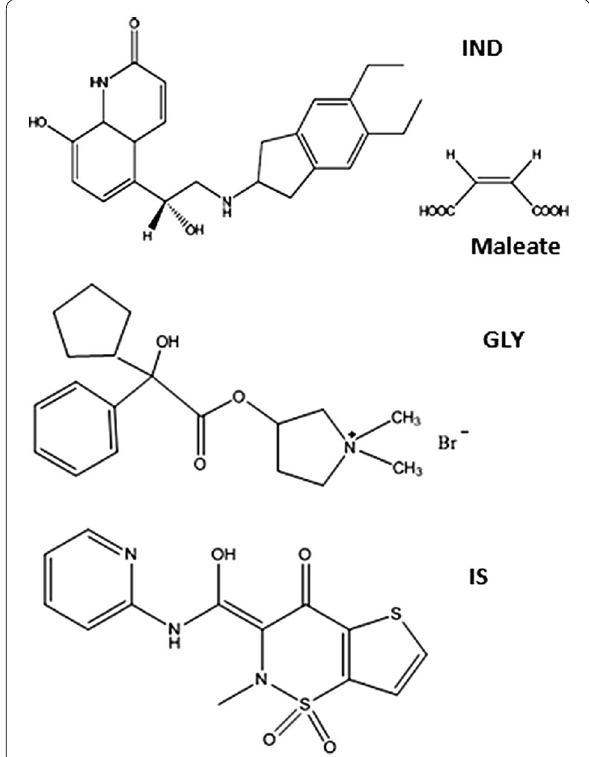
Fig. 1 Chemical structures of indacaterol maleate (IND), glycopyrro- nium bromide (GLY) and tenoxicam